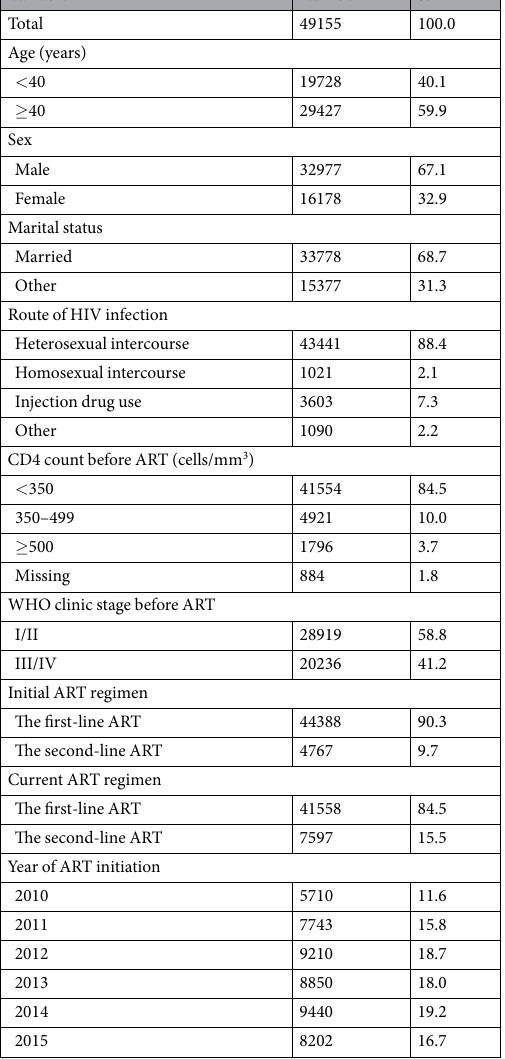
Table 1. Characteristics of HIV patients who initiated ART between 2010 and 2015 in Guangxi, China.